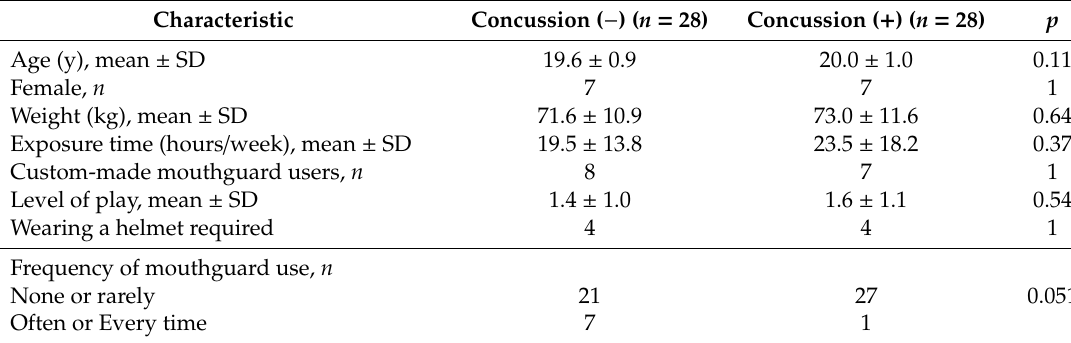
Table 2. Participants’ demographic characteristics and history of concussion within the previous year after propensity score matching ( n =